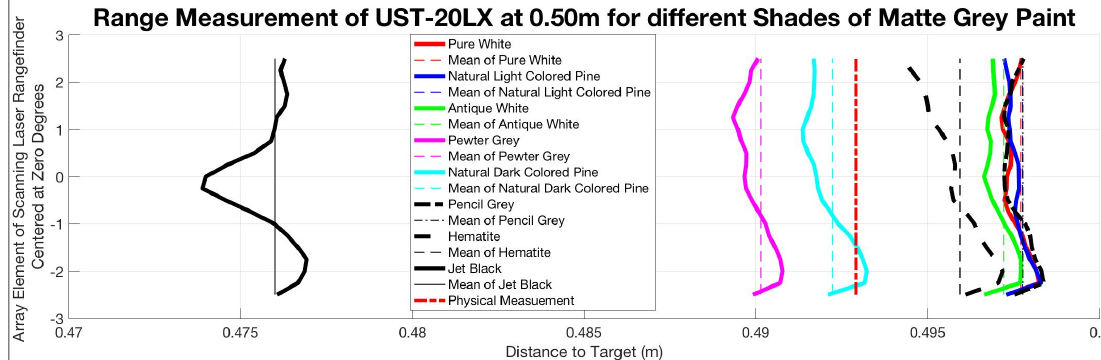
Figure 7. Gray level results at 0.5 m.